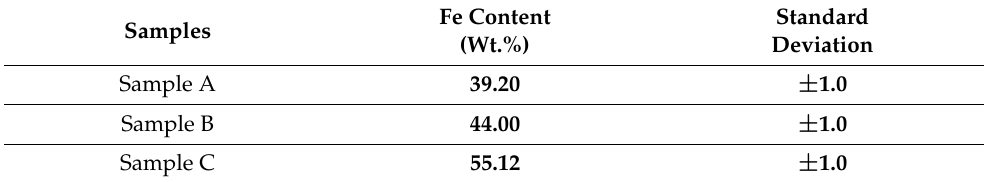
Figure 10. Concentrate from the drum wet weak magnetic separator. Concentrates A, B, and C were obtained at 3 amperes, 4 amperes, and 5 amperes, respectively. Table 1. Chemical analysis of concentrates.